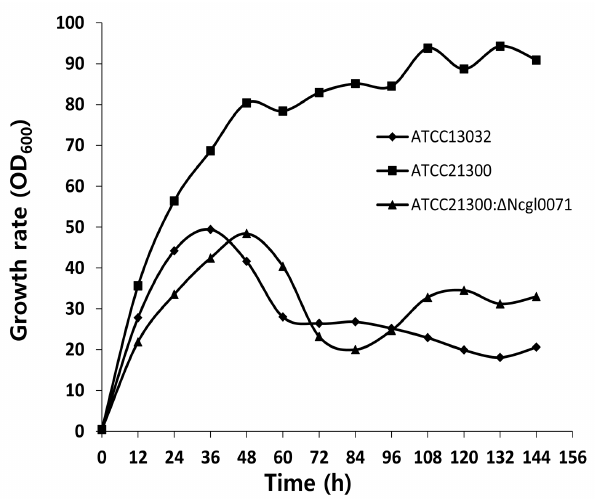
Figure 5. Growth rate of Corynebacterium glutamicum ATCC13032, ATCC21300, and the bioB mutant of ATCC21300.